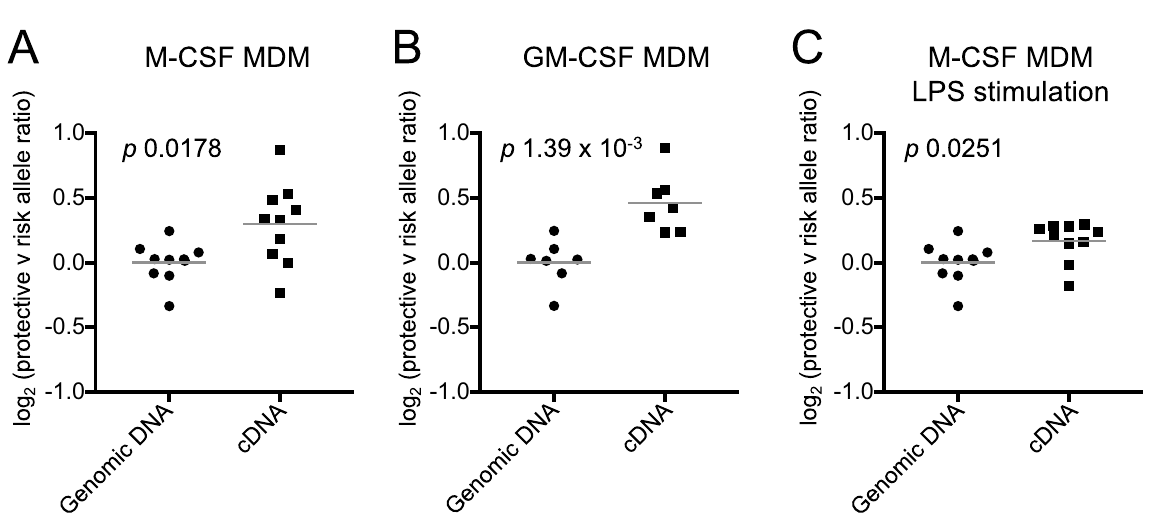
Fig 6. Monocyte-derived macrophages also favor expression of the IBD-protective allele. ( A ) Peripheral blood monocytes from rs6478109 heterozygotes were differentiated into macrophages in the presence of M-CSF (n = 10) or ( B ) GM-CSF (n = 7) before examining allele-specific expression. ( C ) Macrophages derived in (A) were stimulated with LPS for 4 hours before examining allele-specific expression (n = 10, genomic DNA as for panel (A)). ASE was measured at rs4263839 (ratio of A/G reported) in the first intron of TNFSF15 . All individuals were heterozygous at both rs4263839 and rs6478109. rs4263839:A is in phase with the IBD-protective allele rs6478109:A in 1000 Genomes EUR subjects.